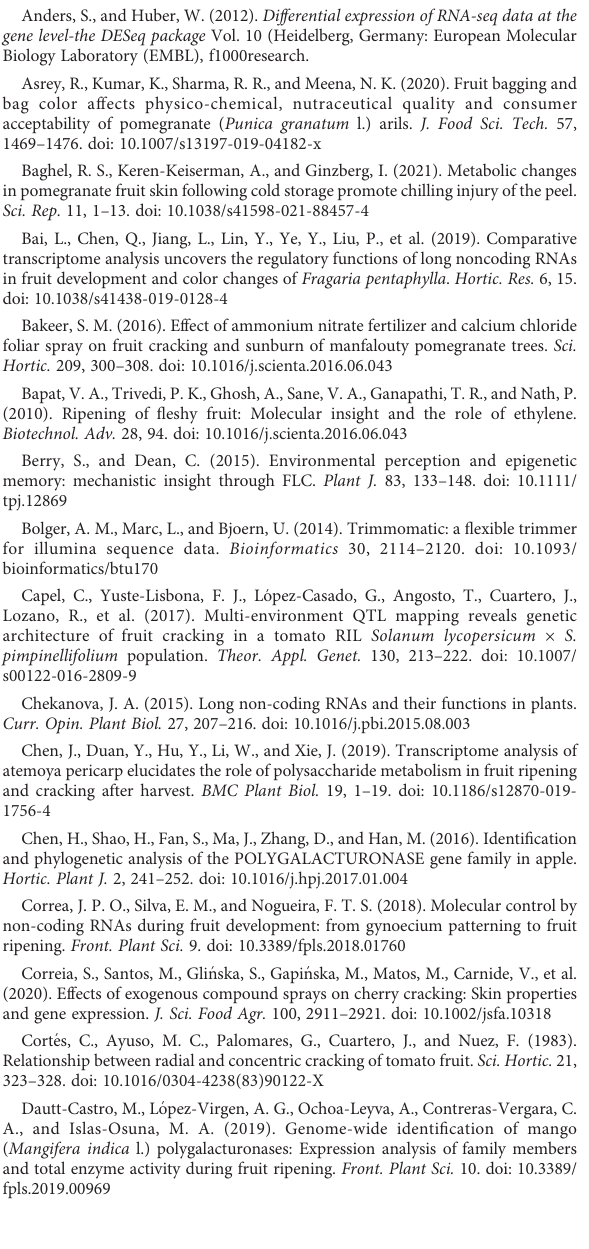
SUPPLEMENTARY FIGURE 1 The expression patterns of ten